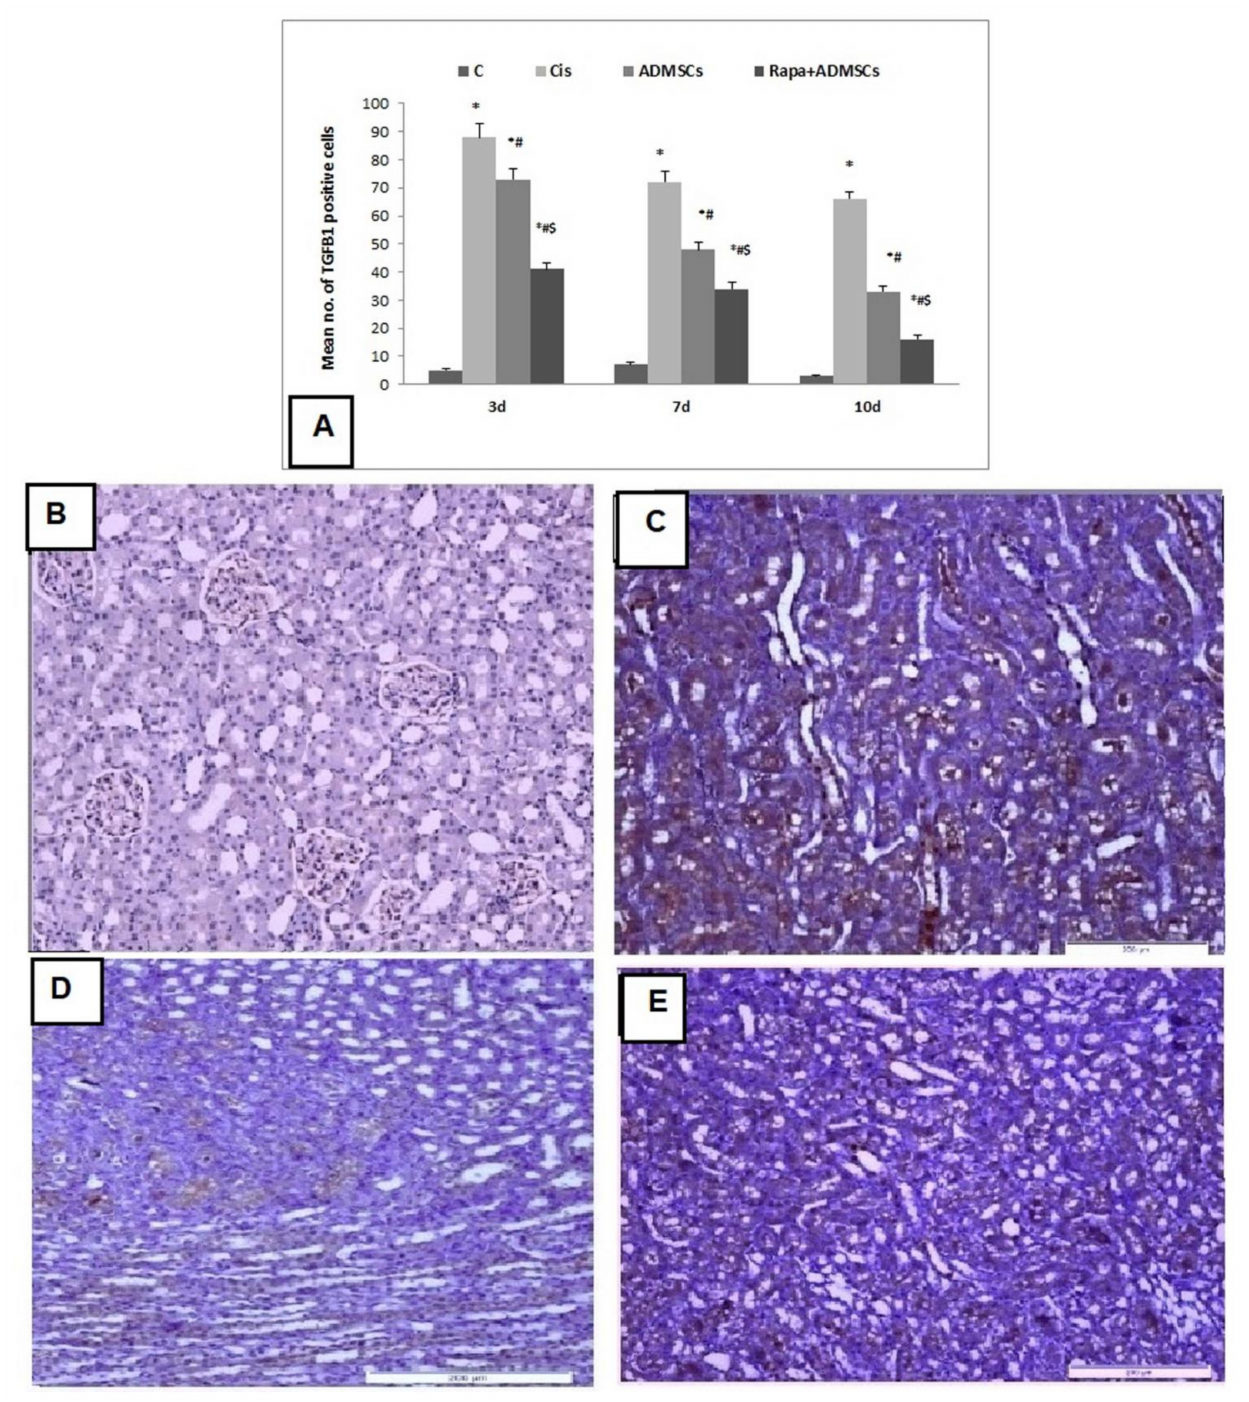
Figure 6. Immunohistochemical analysis of TGF- β 1 expression in kidney tissues 400 × . ( A ) Im- munoscore of TGF- β 1, ( B ) negative expression in control group, ( C ) marked expression in cisplatin group, ( D ) moderate expression in ADMSC group, ( E ) mild expression in Rapa + ADMSC group. * Significant vs. control, # significant vs. Cis group and $ significant vs. ADMSC